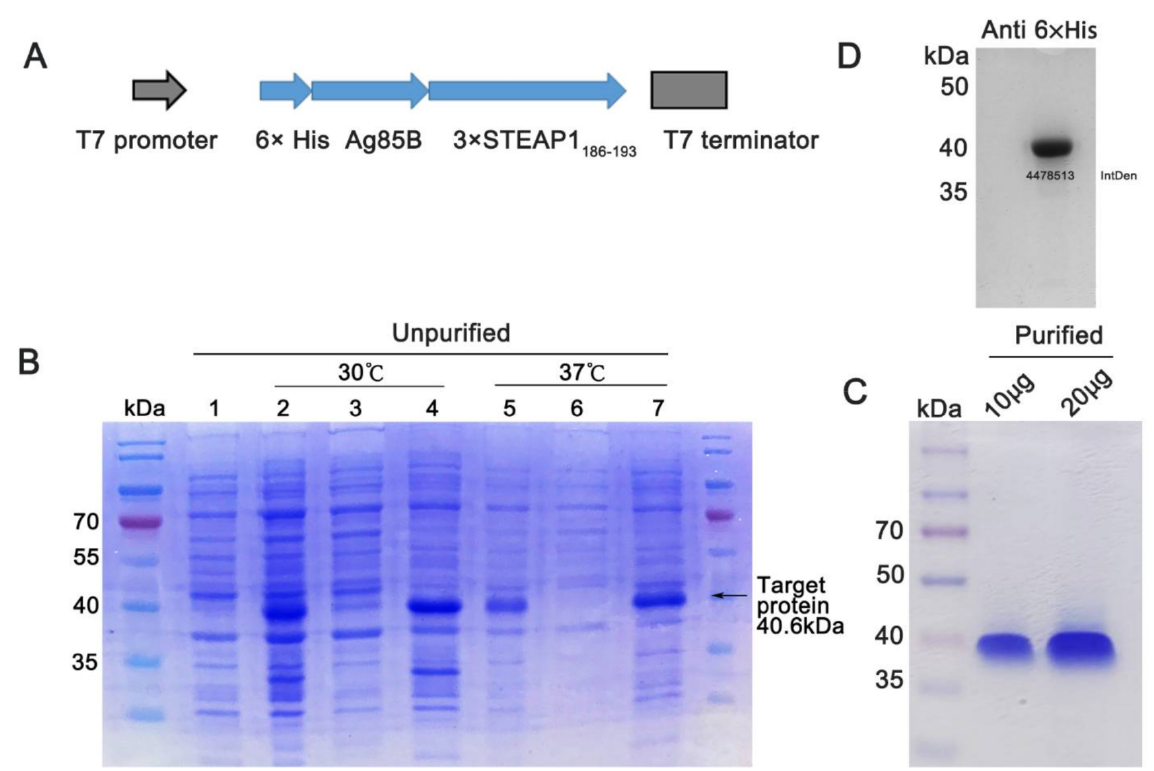
Figure 2. Preparation of fusion protein with pET28a. ( A ) Schematic of pET28a-Ag85B-3 × STEAP1 186-193 plasmid. Ag85B- 3 × STEAP1 186-193 fragment was inserted into pET28a between NheI and XhoI sites using the In-Fusion cloning method. ( B ) 10% SDS-PAGE analysis of total protein of Rosetta(DE3); the protein was stained using Coomassie Brilliant Blue. Lane 1: Rosetta(DE3) control; Lane 2, total Rosetta(DE3) lysate, IPTG induced at 30 ◦ C; Lane 3, Rosetta(DE3) lysate supernatant, IPTG induced at 30 ◦ C; Lane 4, Rosetta(DE3) lysate precipitation, IPTG induced at 30 ◦ C; Lane 5, total Rosetta(DE3) lysate, IPTG induced at 37 ◦ C; Lane 6, Rosetta(DE3) lysate supernatant, IPTG induced at 37 ◦ C; Lane 7, Rosetta(DE3) lysate precipitation, IPTG induced at 37 ◦ C. ( C ) Coomassie Brilliant Blue staining of purified fusion protein. ( D ) Western blotting of purified fusion protein. IntDen: Integrated